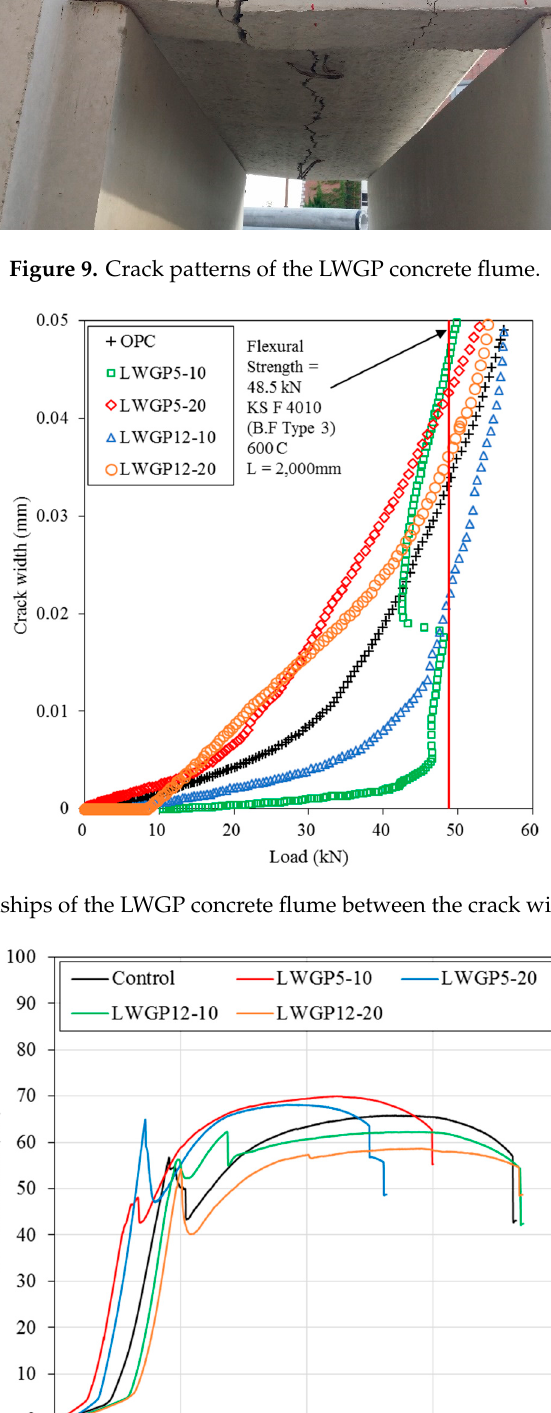
Figure 11. Flexural load–displacement curve of the LWGP reinforced concrete flumes.